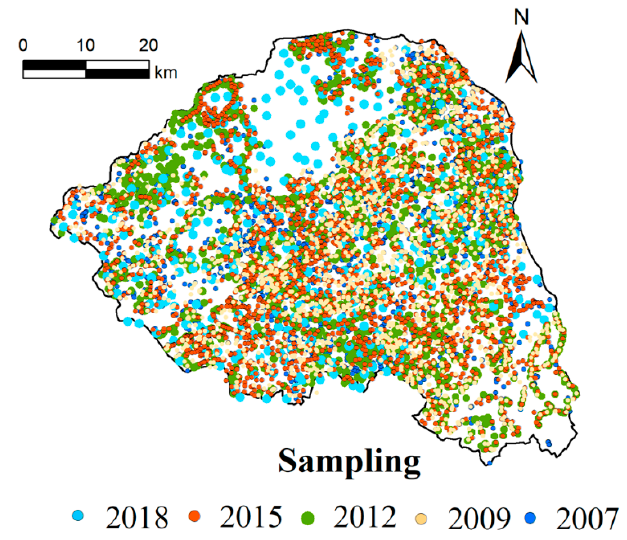
Figure 3. Soil sampling locations of the study area in 2007, 2009, 2012, 2015, and 2018.